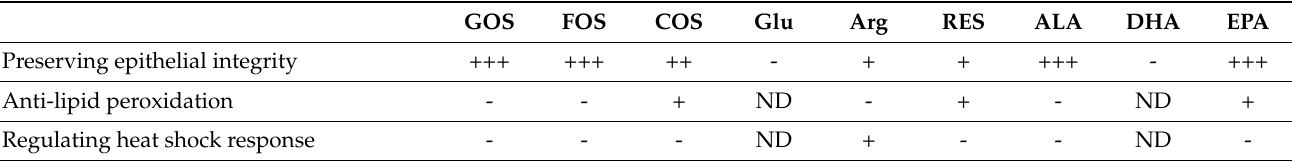
Table 1. The effects of nutritional components on heat/hypoxia-induced intestinal epithelial